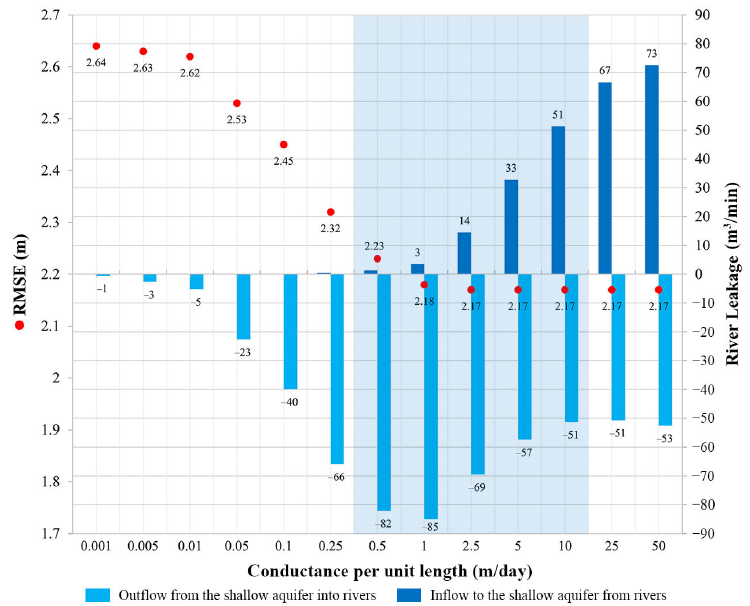
Figure 8. Conceptual analysis of river conductance for February 2016. Low values of conductance per unit length generate gaining conditions, and high values simulate losing conditions. The shaded area encompasses the range of expected values. Red dots indicate RMSE value with the associated RMSE value (label).